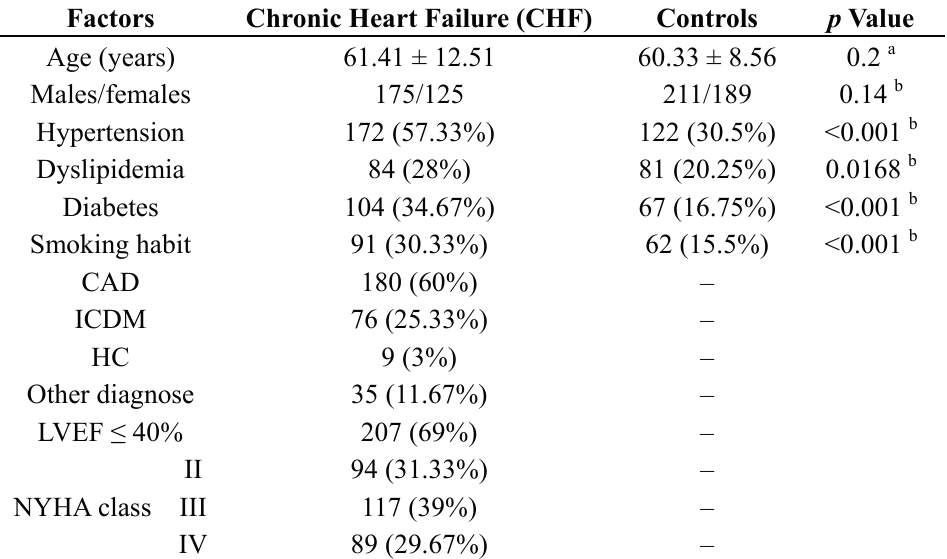
Table 1. Demographic and clinical characteristics of study